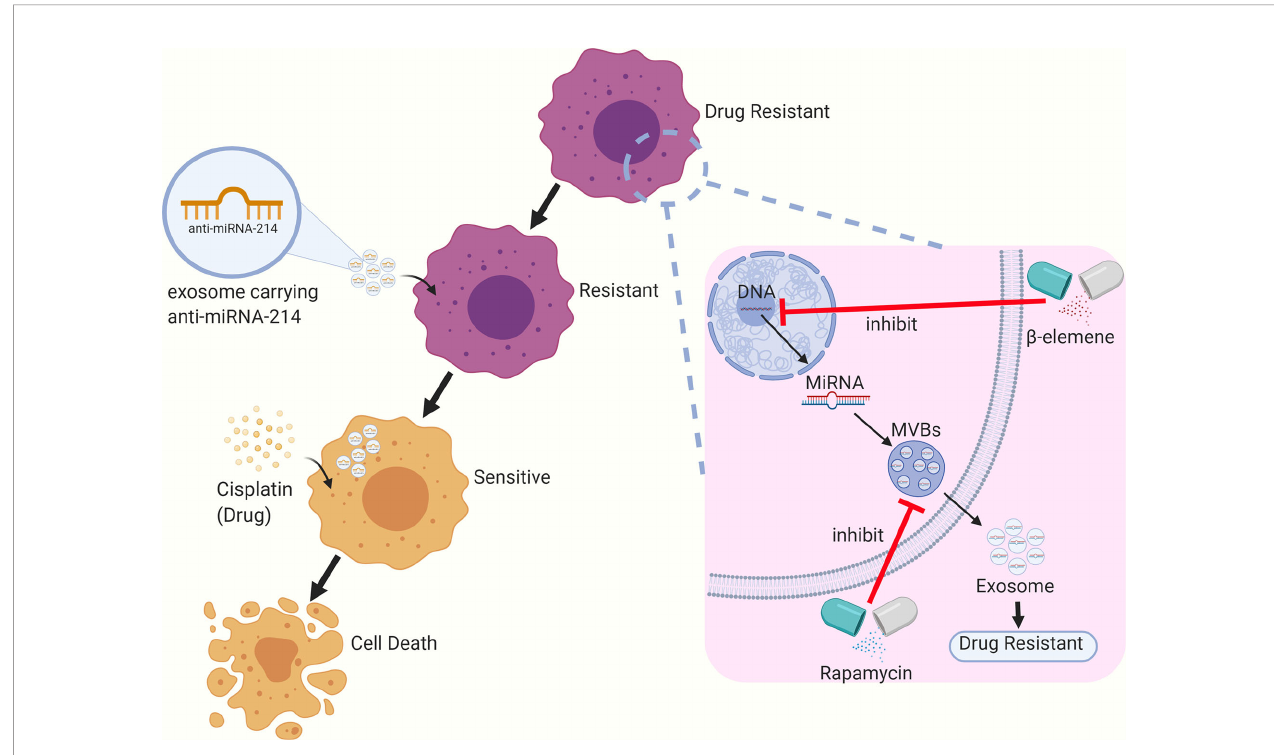
FIGURE 2 | The role of exosomes in the treatment of tumor drug